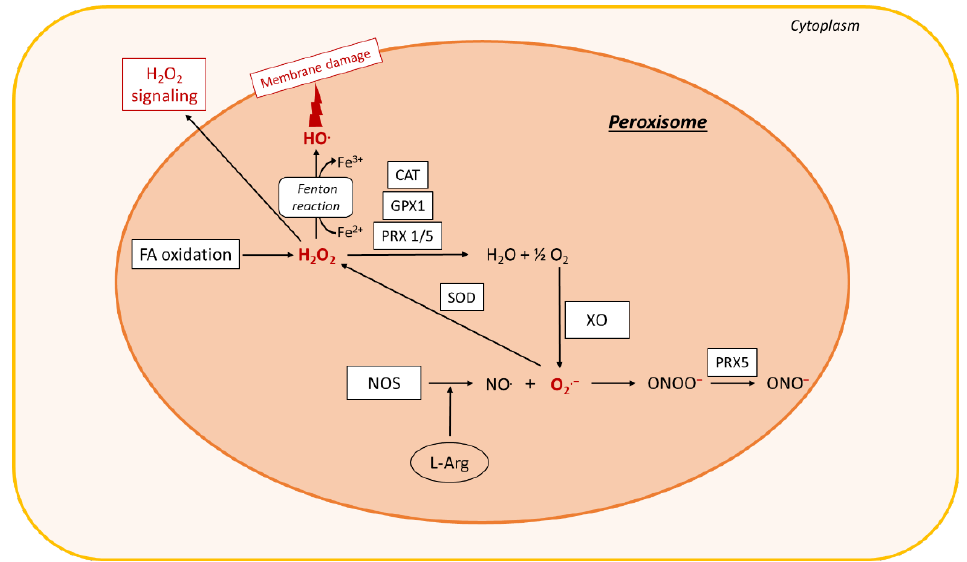
Figure 3. ROS production in peroxisomes. In peroxisomes, fatty acid (FA) oxidation leads to the formation of H 2 O 2 , which is decomposed by the antioxidant enzymes GPX1, CAT, or peroxiredoxin (PRX) 1 or 5, leading to the formation of O 2 and H 2 O. O 2 can react with XO to produce O 2. − . Nitric oxide